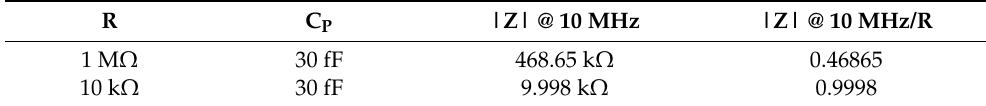
Table 1. Calculated impedance of two different resistor values but identical packaging.